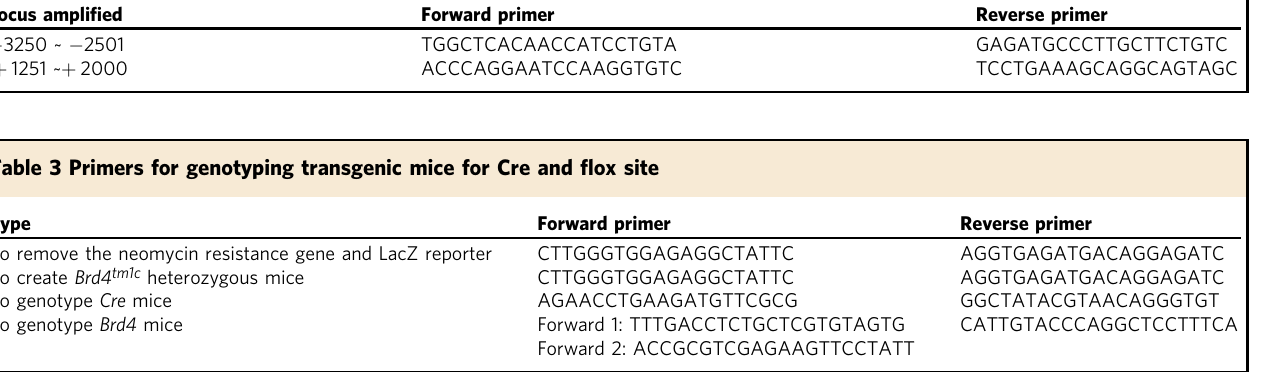
Table 2 Primers for ampli fi cation of Gli1 locus in the Chromatin immunoprecipitation assay Locus ampli fi ed